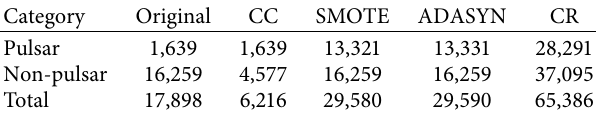
Table 7: Number of samples for pulsar and non-pulsar samples for data resampling after data